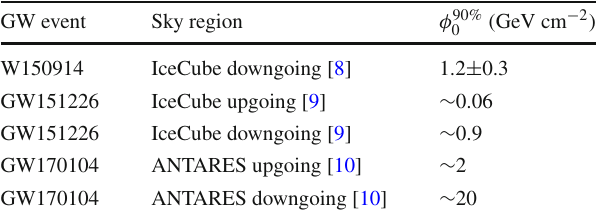
Table3 Averageupperlimitinsidethe90%CLcontourfortheprevious GW-neutrino follow-up analyses